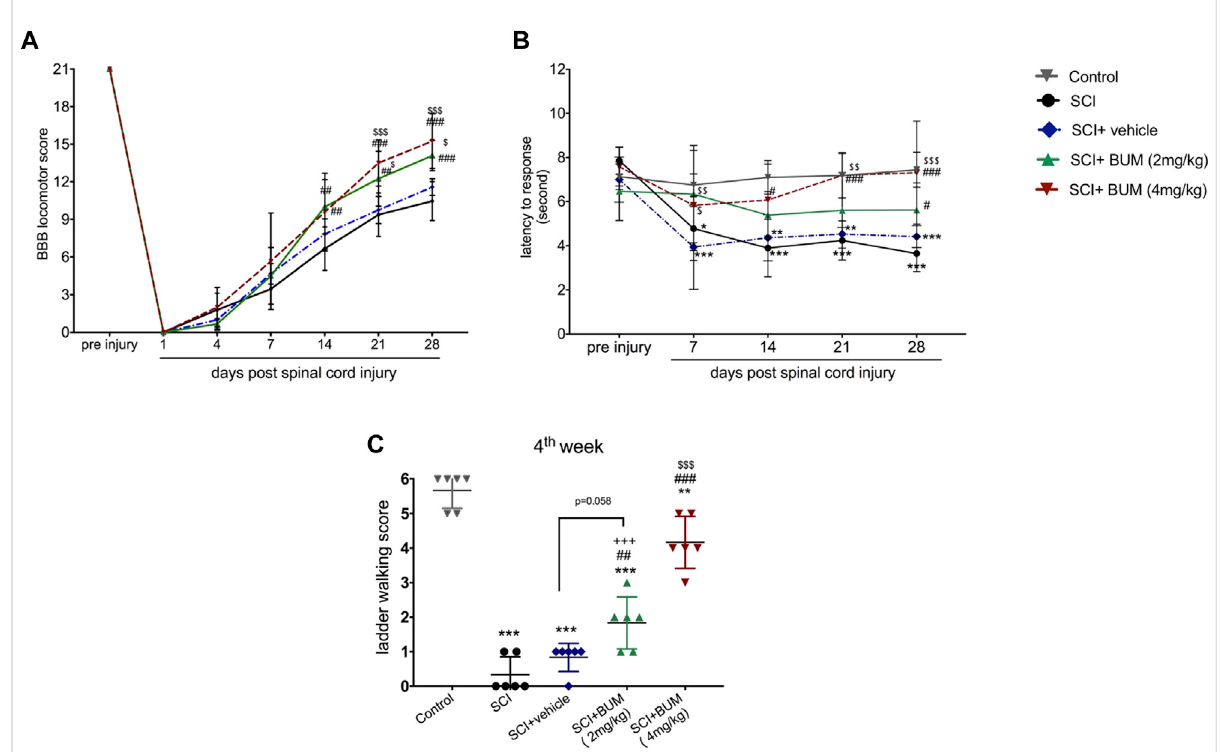
FIGURE 3 Bene fi cial effect of early and repeated intraperitoneal administration of bumetanide on functional recovery after SCI. (A) Improvement in the BBB scale after SCI in the bumetanide treatment group. The Bum 4 mg/kg rats demonstrated superior BBB score with signi fi cant recovery than the SCI and vehicle group. (B) . Analgesic effect of early bumetanide treatment on thermal hyperalgesia in rats with contusion spinal cord injury. Bumetanide reversed thermal hyperalgesia induced by SCI during 28 days. (C) Foot fault scoring of rats on the horizontal ladder walking test analyzed using qualitative ratings for limb placement and accuracy at 4 weeks after SCI. Both bumetanide treatment groups showed signi fi cant differencesfromtheSCIgroup.Bum4 mg/kgshowedthehighestscoreat4 weeks.* p ≤ 0.05,** p ≤ 0.1,*** p ≤ 0.001vs.controlgroup;## p ≤